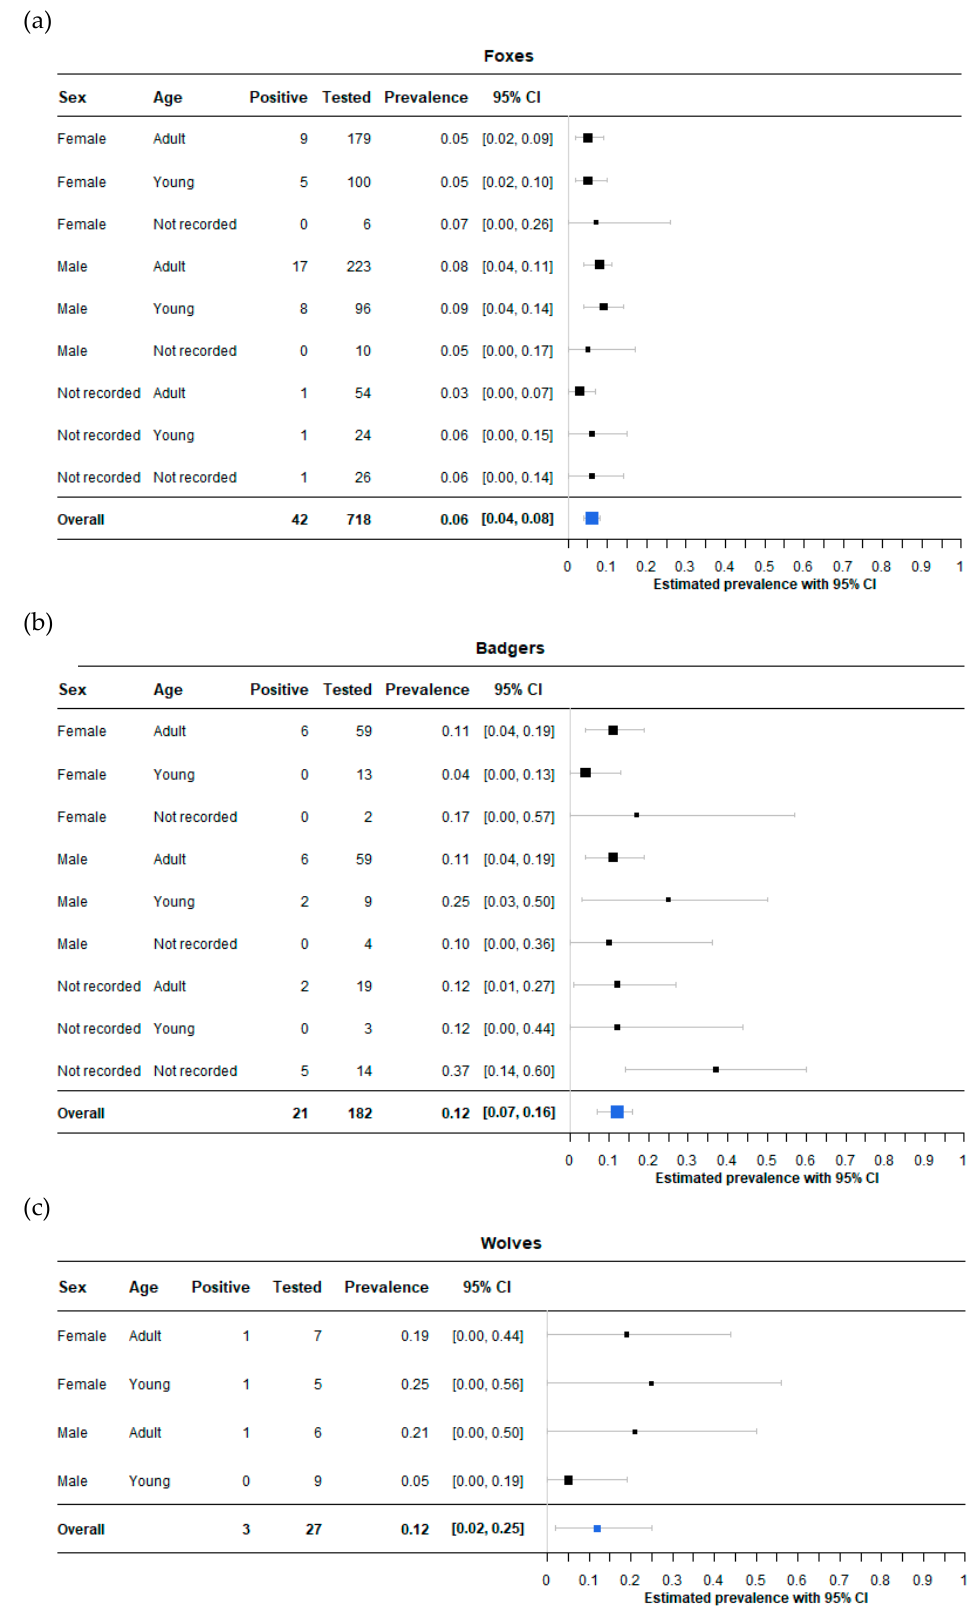
Figure 3. Number of the tested and positive foxes ( a ), badgers ( b ) and wolves ( c ) divided by age and gender and respective Bayesian posterior estimated prevalence with 95% credibility interval.